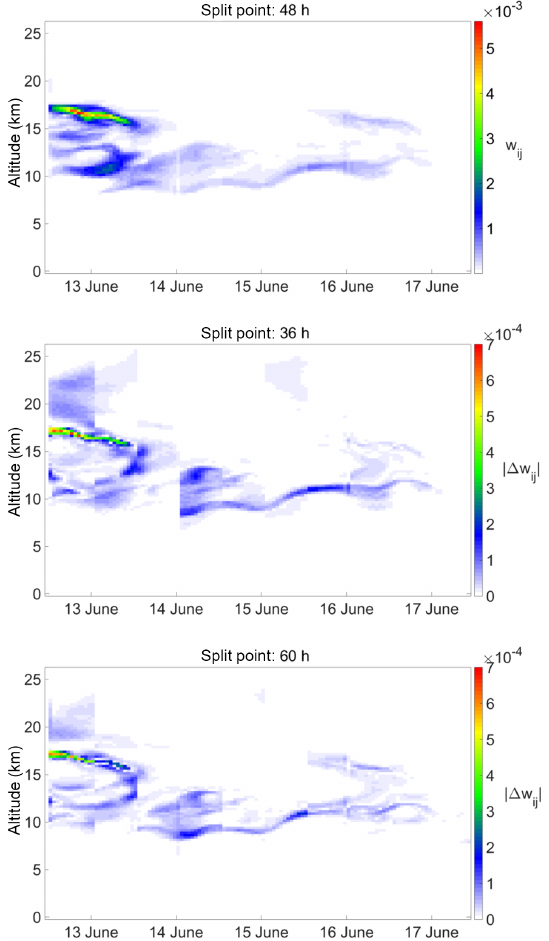
Figure 8. Sensitivity analysis for the product rule parameter n (cid:48) timated importance weights w ij for choosing 23 June 00:00 as the final time of used satellite data and 48h as the split point (top); abso- lute differences of estimated importance weights | (cid:49)w ij | for choos- ing 48h as the split point and those for choosing 36h (middle) and 60h (bottom) as split